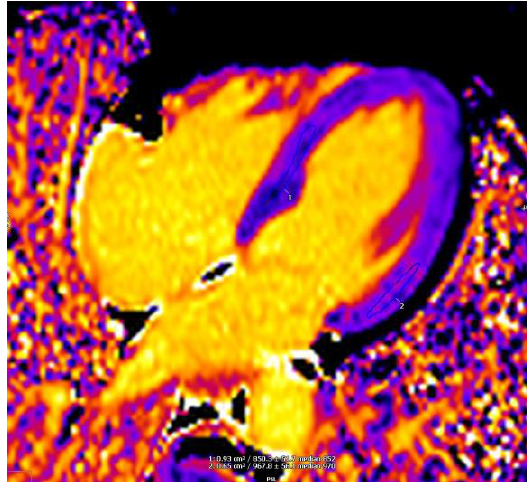
Figure 5. T1 mapping sequence shows a lower T1 time in the posterior interventricular septum in an AFD patient.